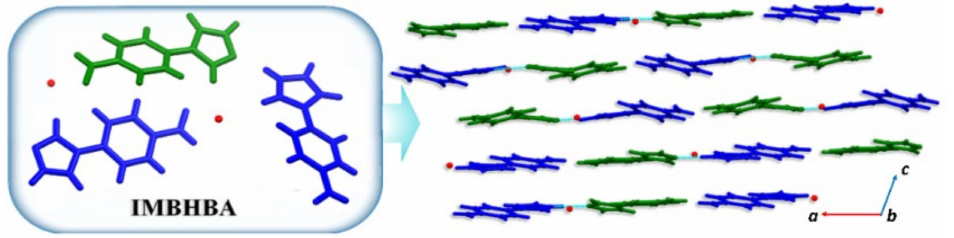
Figure 3. The asymmetric unit and crystal packing of IMBHBA (along b